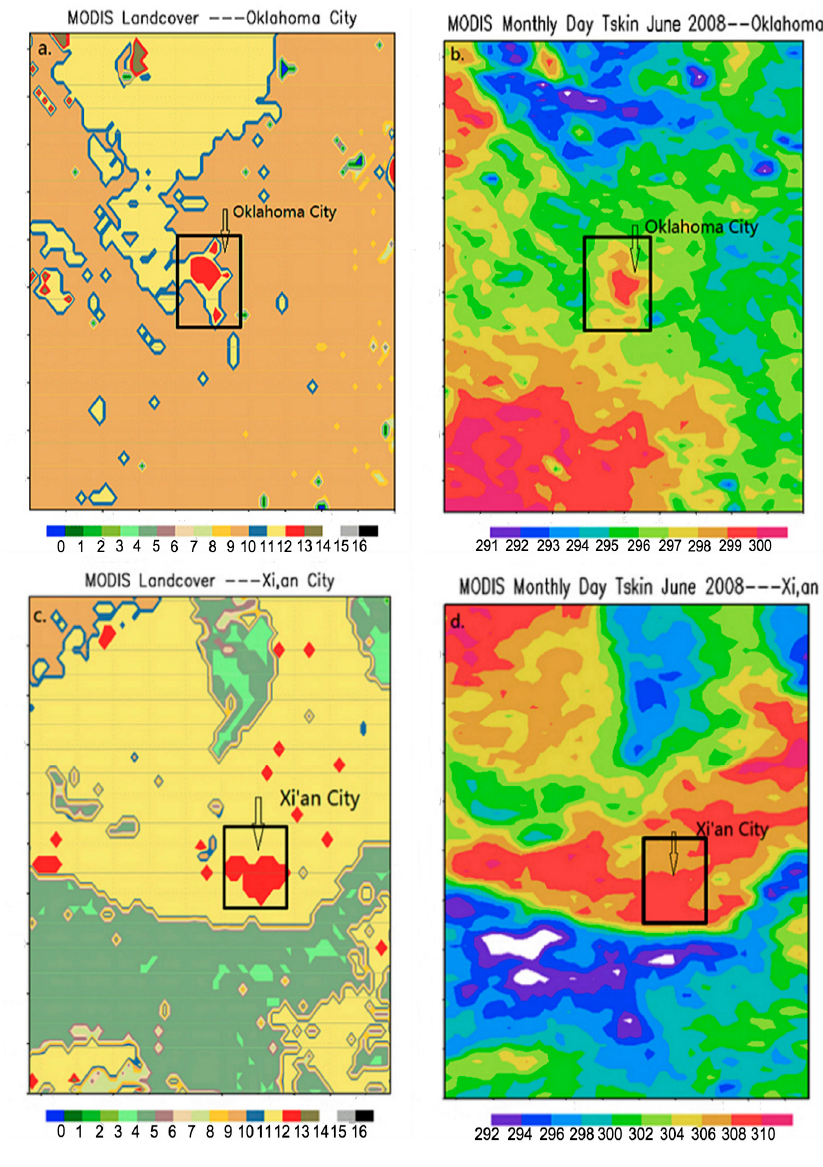
Figure 4. MODIS land surface cover type of ( a ) Oklahoma and ( c ) Xi’an. MODIS classifies the land cover to 17 differing classifications: (1) Evergreen Needleleaf Forest, (2) Evergreen Broadleaf Forest, (3) Deciduous Needleleaf Forest, (4) Deciduous Broadleaf Forest, (5) Mixed Forest, (6) Closed Shrubland, (7) Open Shrubland, (8) Woody Savannas, (9) Savannas, (10) Grassland, (11) Permanent Wetland, (12) Cropland, (13) Urban and Built-up, (14) Cropland/Natural Vegetation Mosaic, (15) Snow and Ice, (16) Barren or Sparsely Vegetated. Urban area is the red color in the mapped areas. Locations of OKC and Xi’an City are marked in the figures. MODIS monthly daytime land surface skin temperature (unit in K) was recorded in June 2008 by Terra at 10:30 local time for ( b ) OKC in June 2008 and ( d ) Xi’an City.